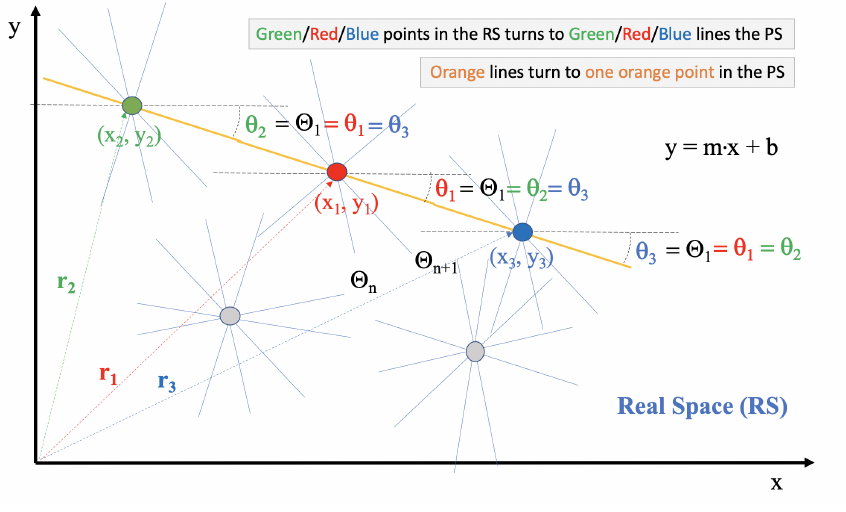
Figure 1. Hough transform conversion for Formula y = x · m + b in Real Space .